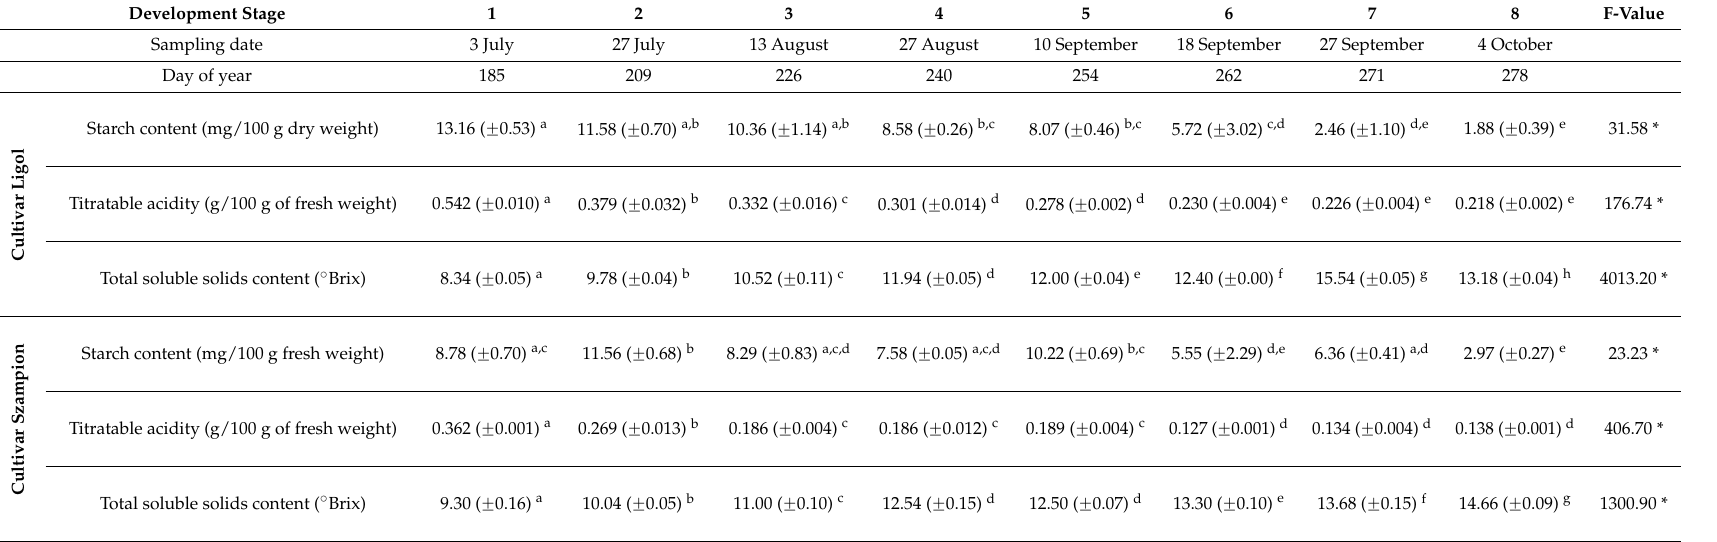
Table 1. Characteristics of apple maturity states expressed as the average values of measured parameters. In parenthesis standard